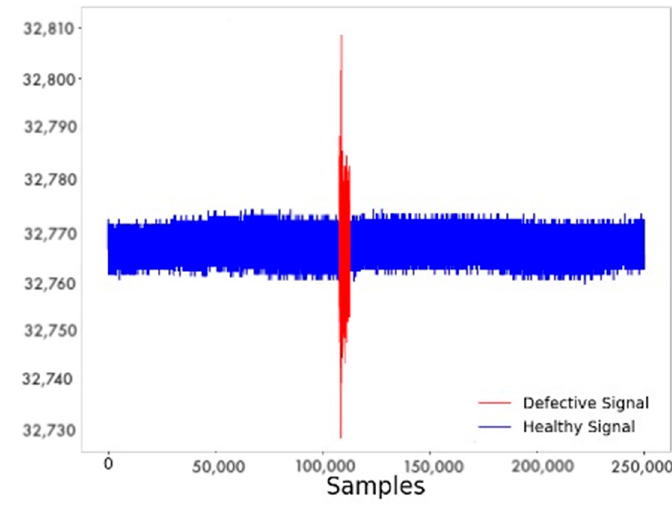
Figure 5. Example of leakage detection using LSTM AE.